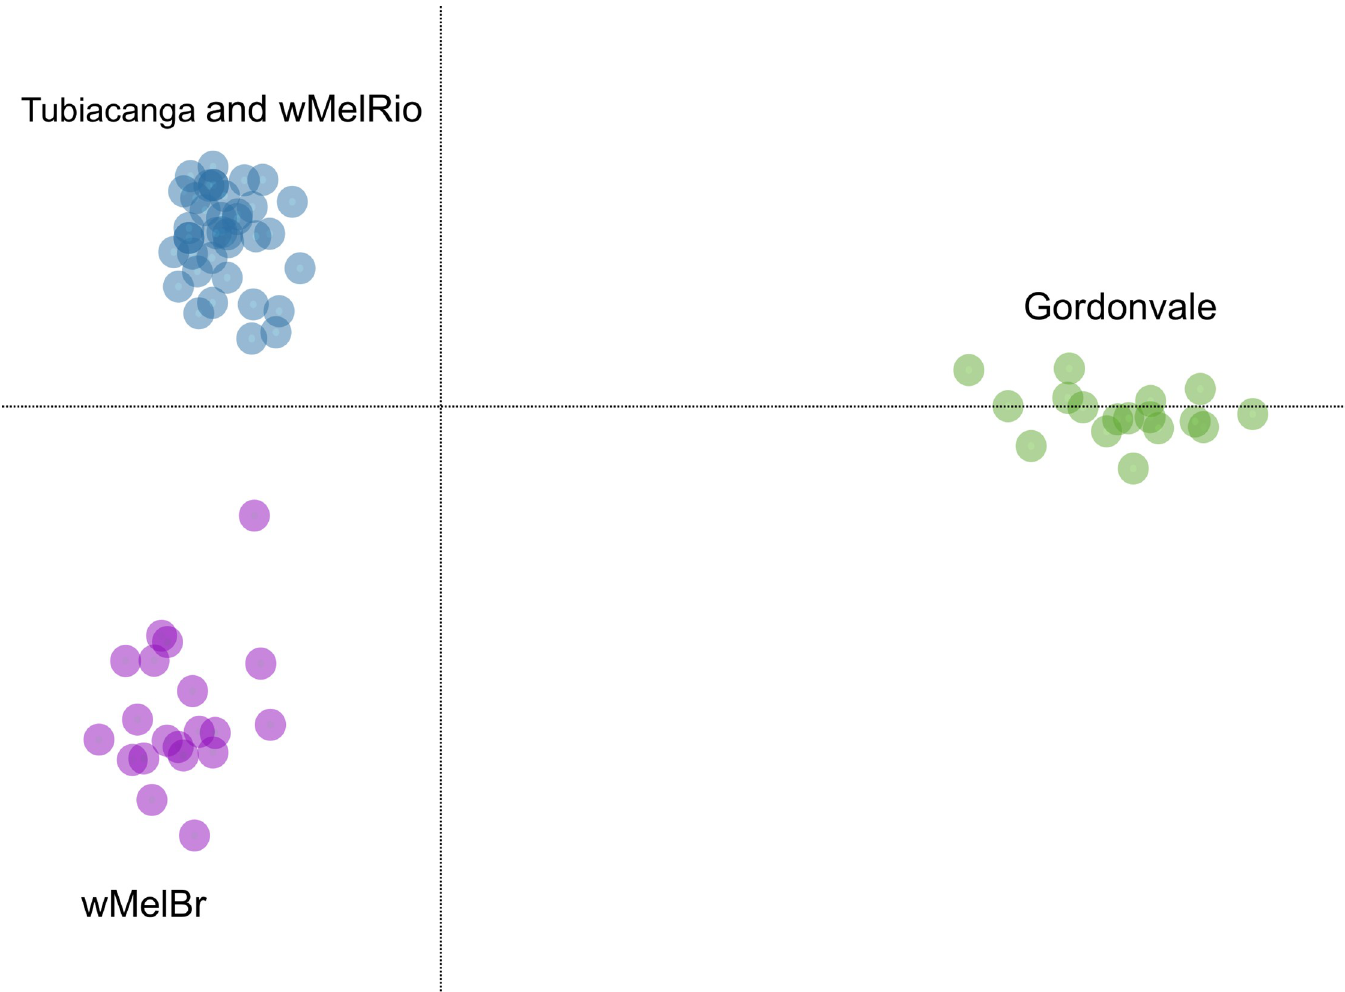
Fig 6. Genetic similarities and differences among w MelBr, w MelRio, Tubiacanga (Rio de Janeiro, Brazil) and Gordonvale (Cairns, Australia) Aedes aegypti mosquitoes as visualized by a DAPC analysis on > 5000 SNPs, with data plotting samples for the two main